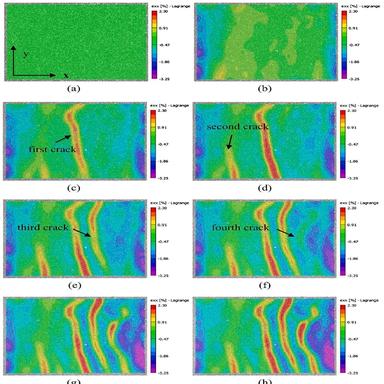
Process of plastic shrinkage cracking in the fresh cement paste exposed to an environmental chamber. Images captured at (a) 0 min, (b) 10 min, (c) 28 min, (d) 30 min, (e) 32 min, (f) 34 min, (g) 40 min, and (h) 90 min . The copyright permission for this figure has been granted.